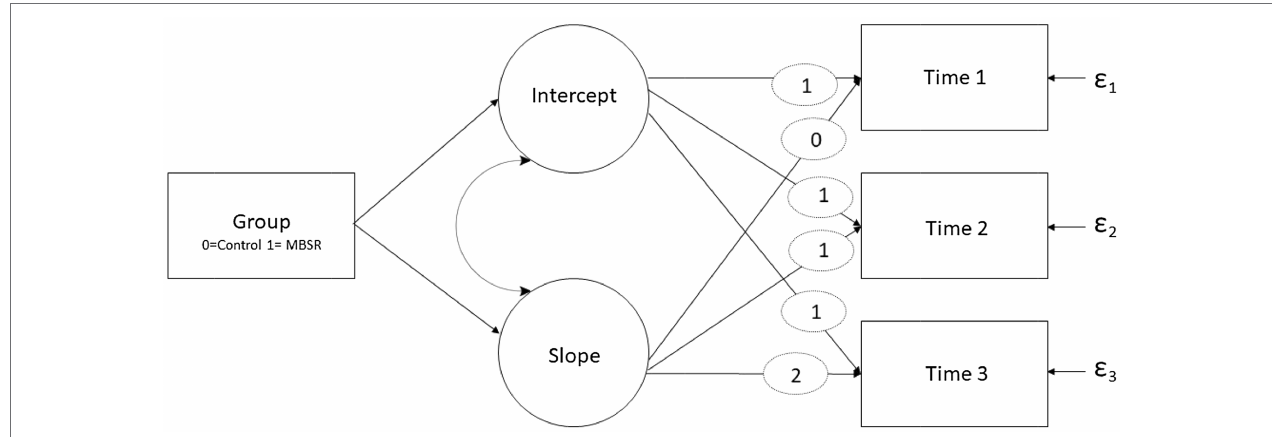
FIGURE 2 | An illustration of the individual growth curve model. The rectangles represent observed variables, while the circles represent latent factors. Curved arches represent correlations and ε represents residual random parts. Fixed weights for intercept and time weight for slopes are represented by ellipses.